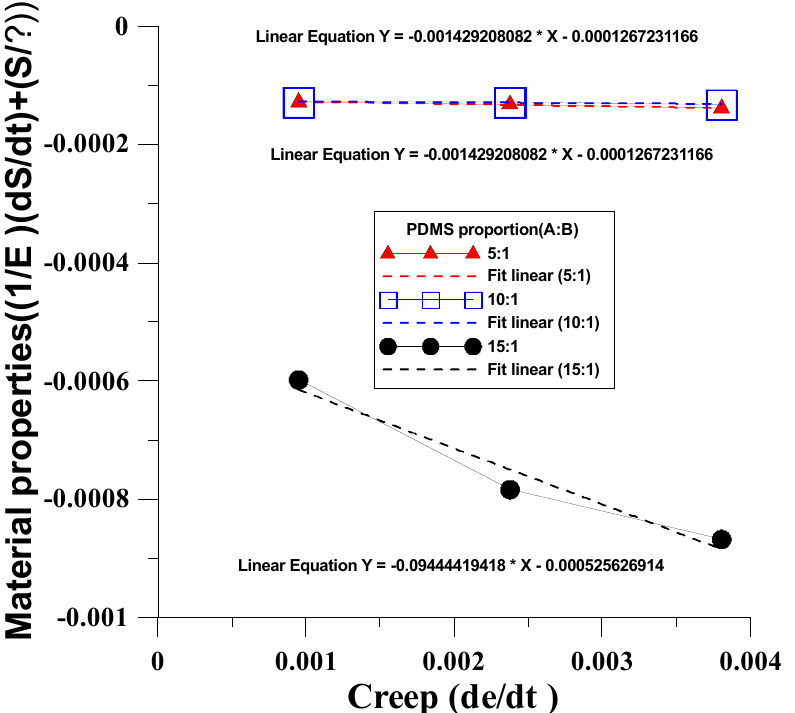
Figure 10. Time-dependent creep behavior of the dependent variables in the dynamic tensile process of the Kelvin–Voight model.